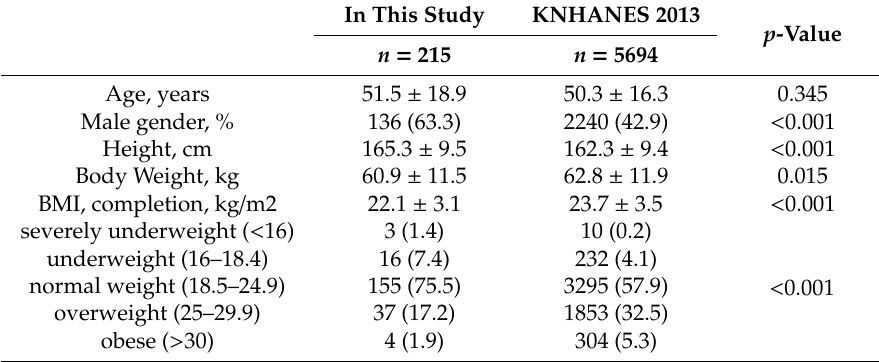
Table 4. Comparison of demographics between enrolled 215 cases on completion of anti-TB treatment and 5694 cases of KHANES data in